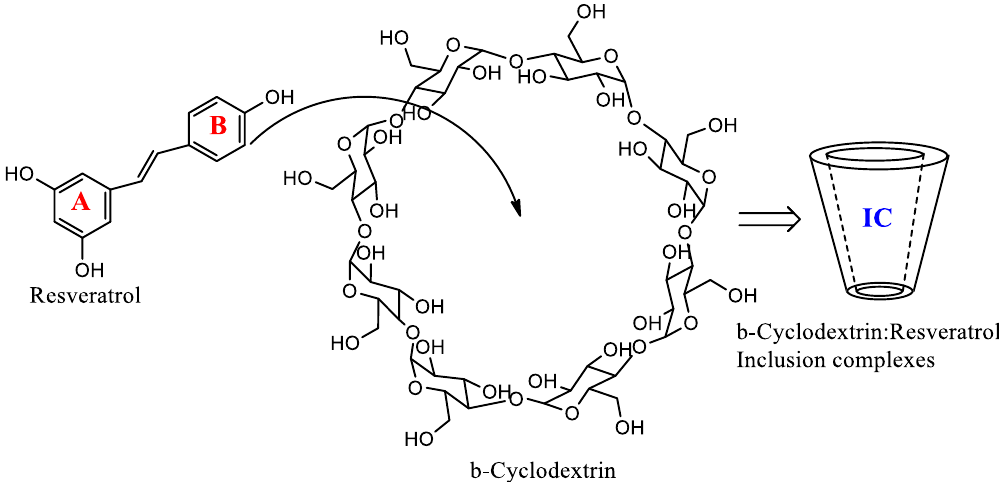
Figure 1. Structural formulae of resveratrol contain aromatic rings A and B , β -cyclodextrin, and inclusion complexes (IC).